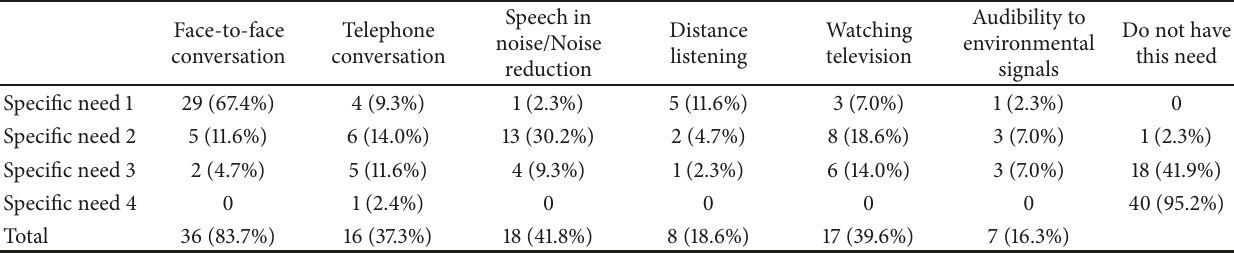
Table 5: COSI specific needs nominated by participants at Visit